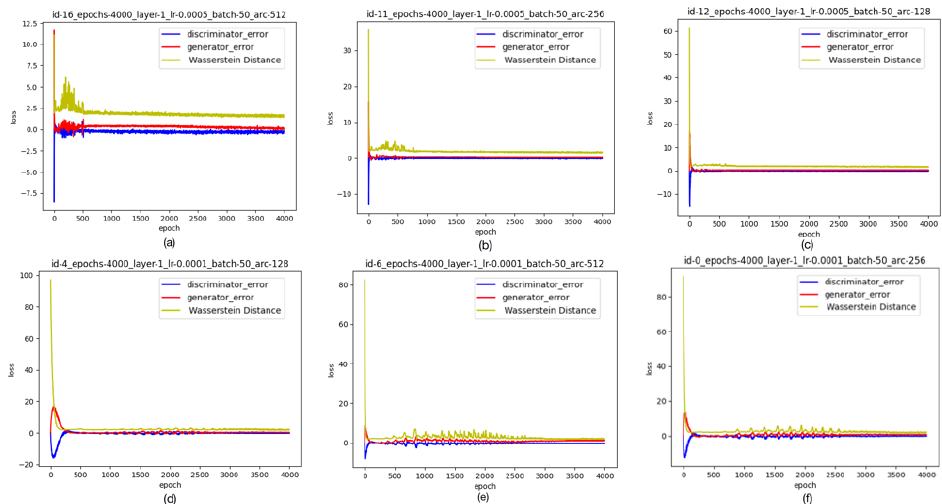
Figure 2. We used the Wasserstein distances as the supervision of the model training degree and the basis for selecting synthetic data. ( a ): Ir = 0.005, arc = 512; ( b ): Ir = 0.005, arc = 256; ( c ): Ir = 0.005, arc = 128; ( d ): Ir = 0.0001, arc = 128; ( e ): Ir = 0.0001, arc = 512; ( f ): Ir = 0.0001, arc =